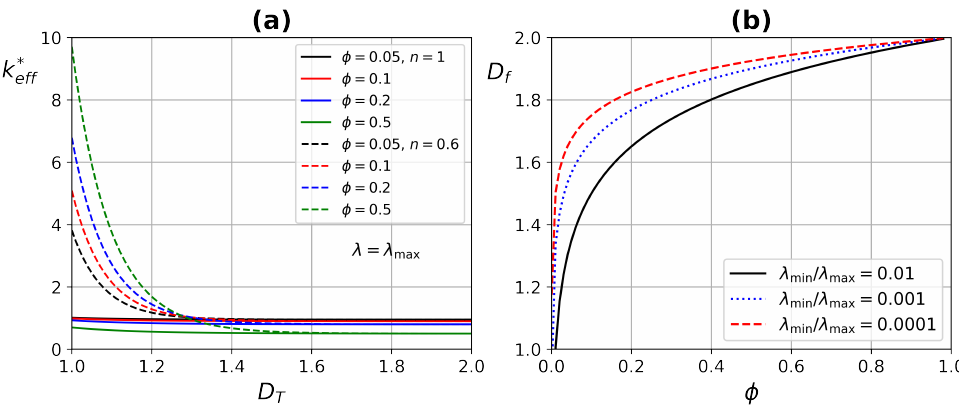
Figure 7. ( a ) Effective thermal conductivity as a function of fractal dimension D T . Continuous lines (Newtonian fluid) and dashed lines (non-Newtonian fluid). ( b ) Fractal dimension D f as a function of porosity, for different ratios λ min / λ max .